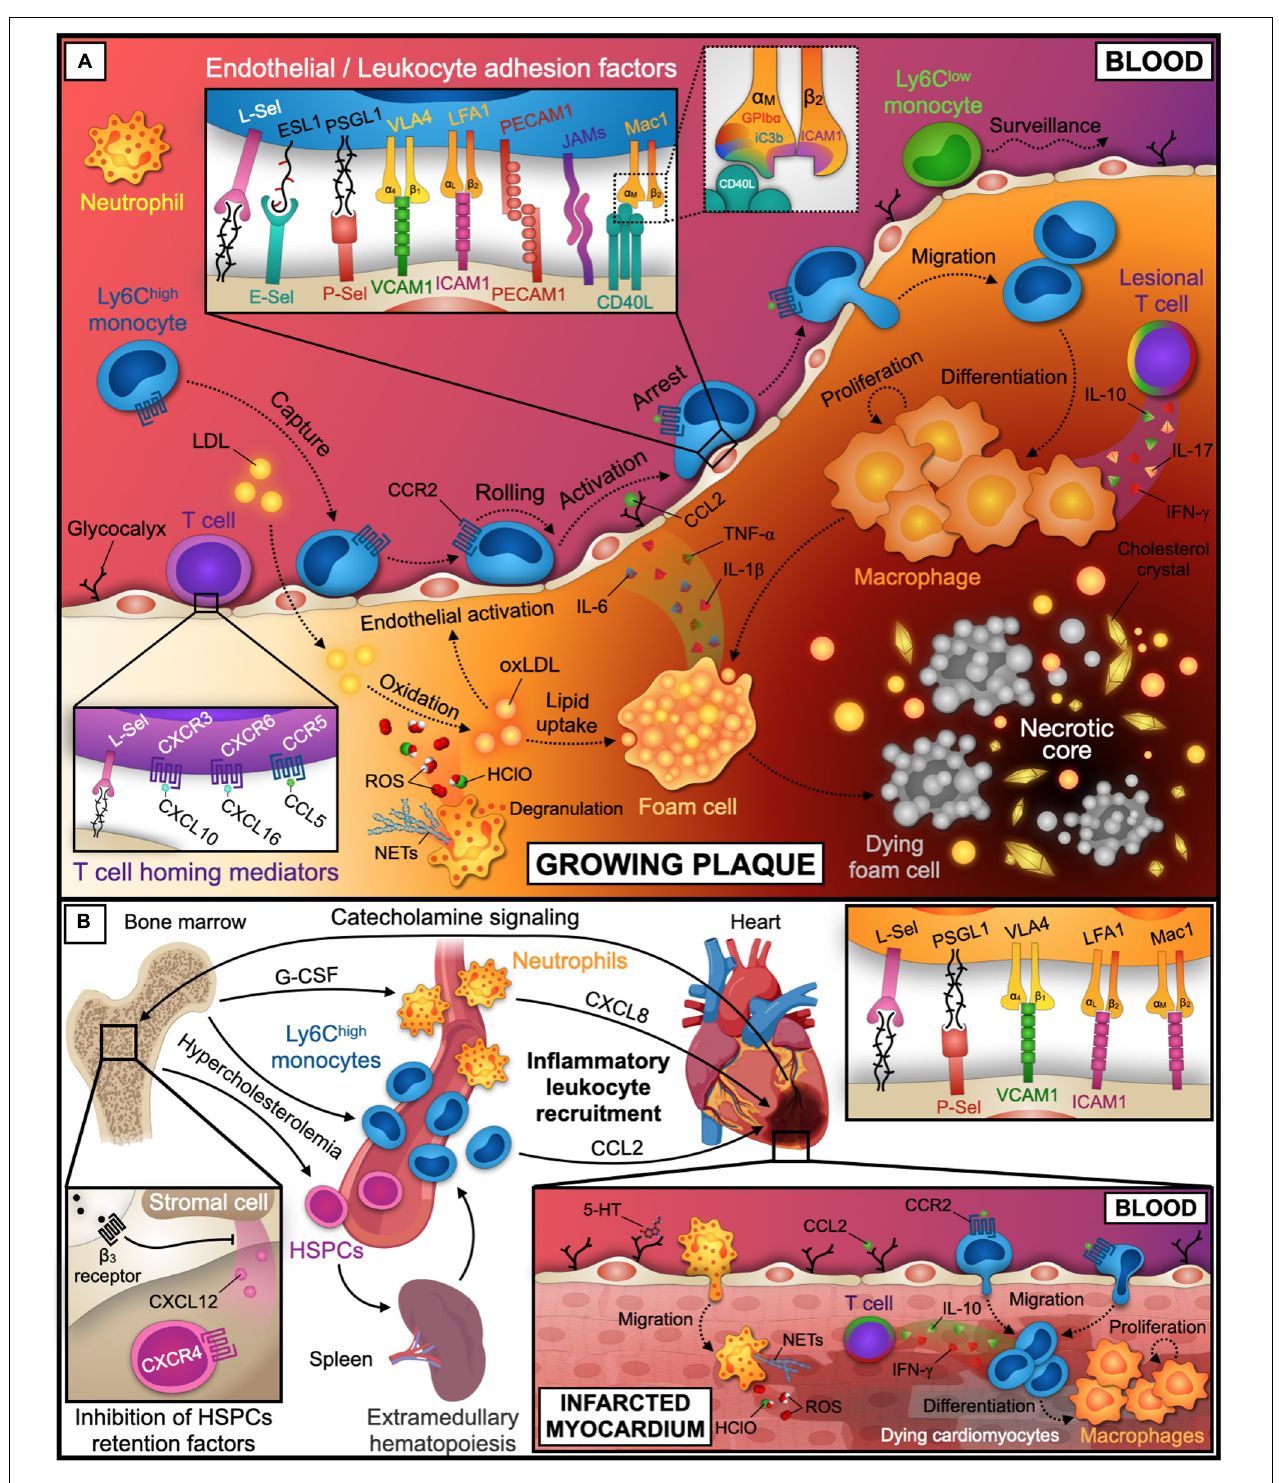
FIGURE 2 | Leukocyte recruitment into the atherosclerotic plaque and infarcted tissue. (A) Initial endothelial dysfunction and activation is promoted by shear stress at sites of turbulent blood flow and lipid accumulation. While Ly6C low monocytes patrol the endothelial surface for tissue surveillance, neutrophils and Ly6C high monocytes are recruited into the subendothelial space. Within the plaque, Ly6C high monocytes differentiate into macrophages. These proliferate, became foam cells, and orchestrate the inflammatory response, eventually die and build the necrotic core together with lipids and cholesterol crystals. These processes are further instructed by plaque-infiltrating T cells. Relevant inflammatory cytokines, chemokines, and receptor-ligand pairs for monocytes and T cells are indicated in the inlays. A third inlay shows CD40L binding to a distinct site within the I-domain of α M chain of Mac-1 that does not interfere with other Mac-1 ligands. (B) Coronary